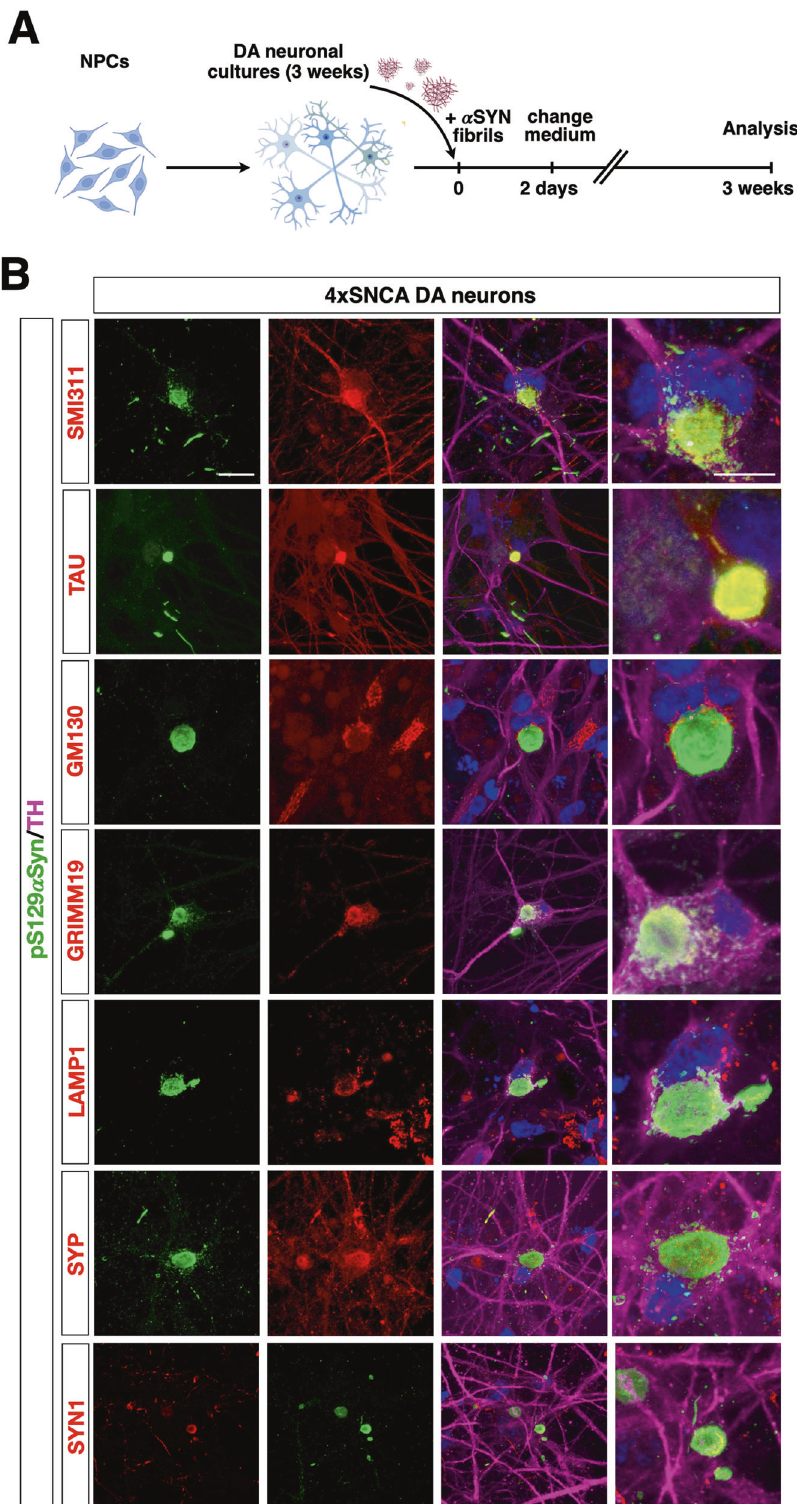
Fig. 6 Generation of Lewy body-like structures in seeded 4xSNCA mDA neurons. A Schematic view of the protocol to intoxicate DA neuronal cultures with P91 α Syn fi brils. B Representative images of Lewy body-like structures stained with different markers for neuro fi lament (TAU), mitochondria (GRIMM19), lysosomes (LAMP1), cis-Golgi membranes (GM130), and synaptic protein (SYN1, SYP). Scale bar, 100 µm.